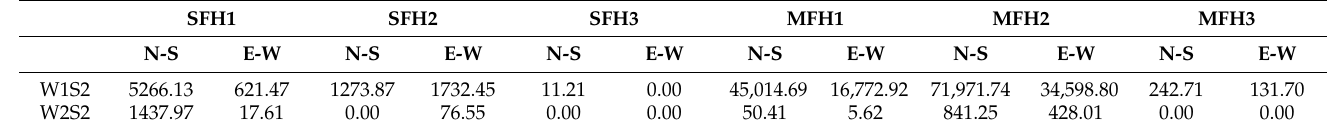
Table 12. Total primary energy savings per year (MW/h) of 100% of EVha building